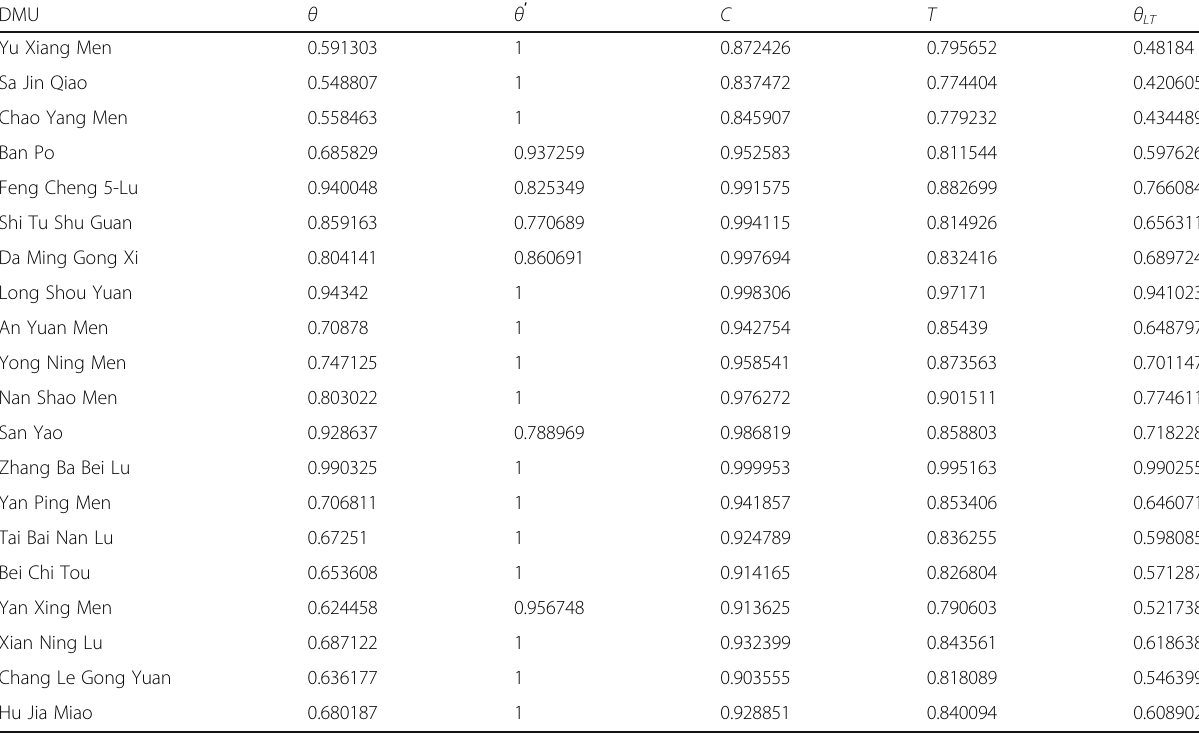
Table 6 Coupling degree statistics of land intensive use and rail transit capacity